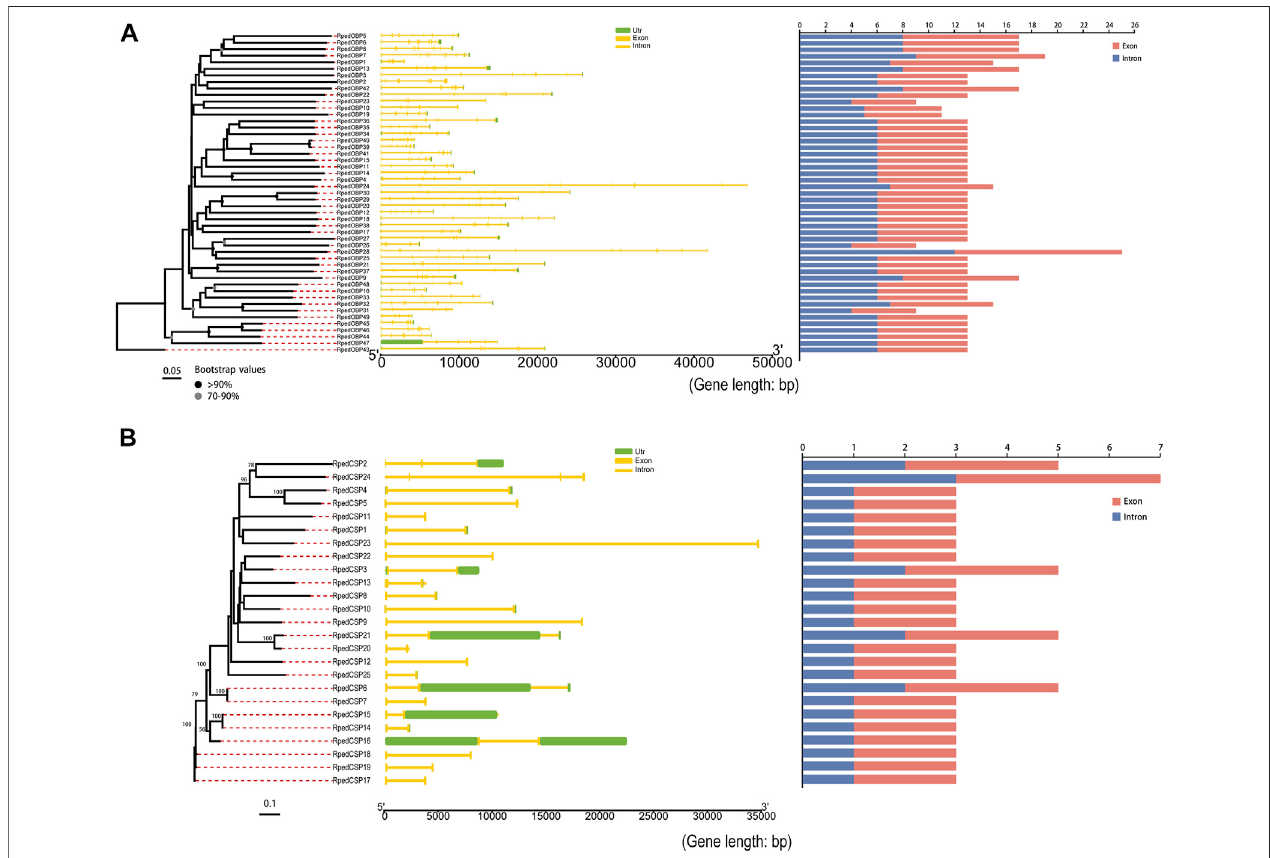
FIGURE 3 | Genomic structure of R. pedestris OBPs and CSPs. Based on the annotation fi le of R. pedestris, we acquired genomic structures of OBP and CSP genes. (A) Numbers of exon/intron and exon/intron structures of RpedOBPs. (B) Numbers of exon/intron and exon/intron structures of RpedCSPs.